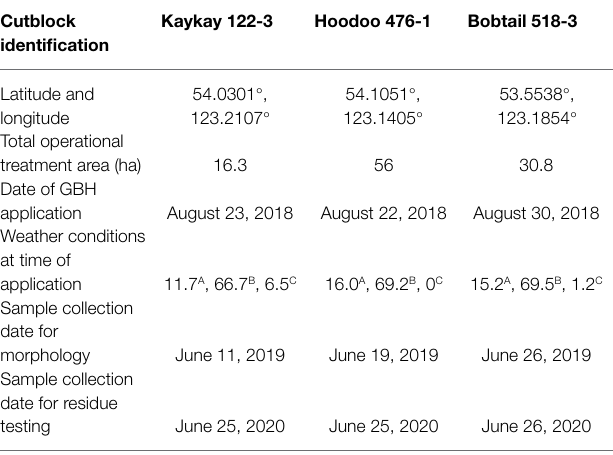
TABLE 1 | Forest cutblock locations treated with glyphosate-based herbicides (GBH) within in northern British Columbia, Canada, where Rosa acicularis was sampled for morphological testing.